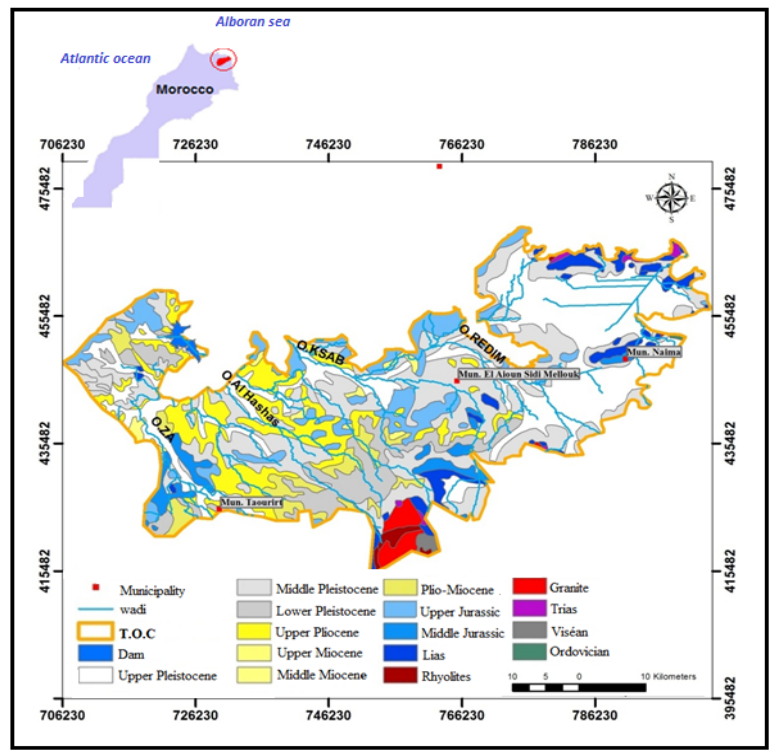
Figure 1. Geological map of the T.O.C. Extracted from Oujda’s map [42].